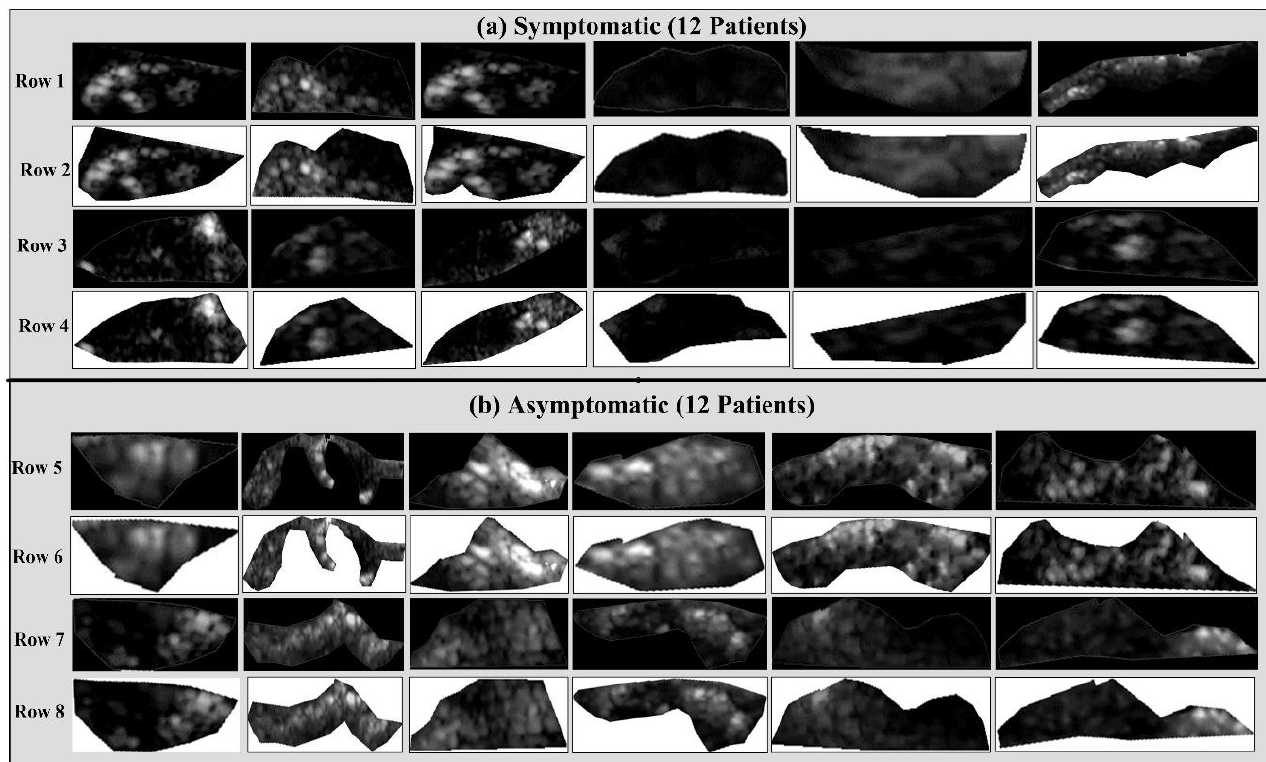
Figure 2. ( a ) Top: symptomatic (row 1 and row 3) and ( b ) down: asymptomatic; (row 5 and row 7): original carotid full scans; row 2, row 4, row 6, and row 8 are the plaque delineated cut sections of ( a ) symptomatic and ( b ) asymptomatic plaques after pre-processing and delineation.